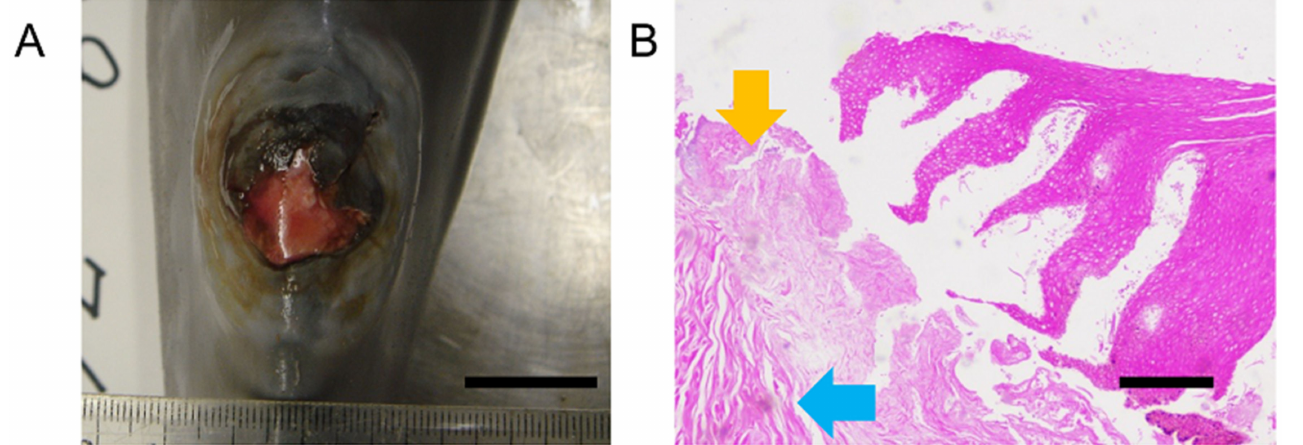
Figure A3. Female calf Indo-Pacific bottlenose dolphin ( Tursiops aduncus ) from the Adelaide Dolphin Sanctuary. ( A ) Excoriation/abrasion on the dorsal peduncle (cause unknown), scale = 2 cm. ( B ) detail of a lesion showing incomplete epidermis, necrotic dermis (yellow arrow), and a reorganized connec- tive tissue layer (blue arrow), scale = 300 µ